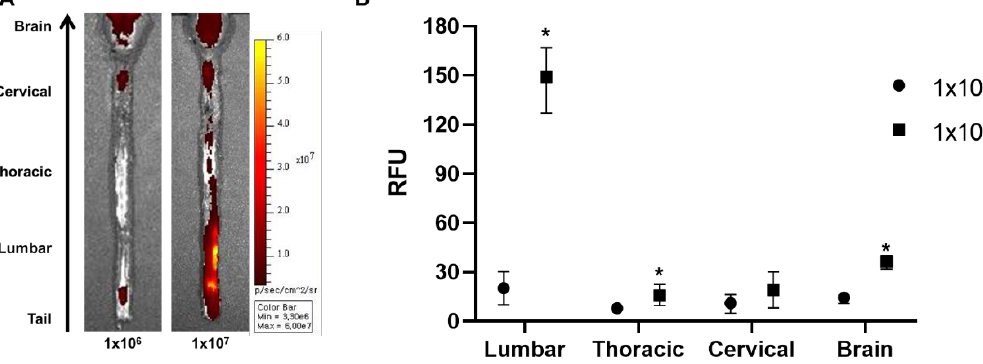
Figure 4. Assessment of the e ff ects of higher injection dose on the intrathecal delivery of WJ-MSCs to the rat brain. An additional injection was performed using a 10-fold higher dose (1 × 10 7 ), and the rats were sacrificed after 12 h. ( A ) Ex vivo optical images were taken. ( n = 3 / group) ( B ) Signal intensities were quantified. Mean with range * p -value < 0.05 compared to the 1 × 10 6 group.